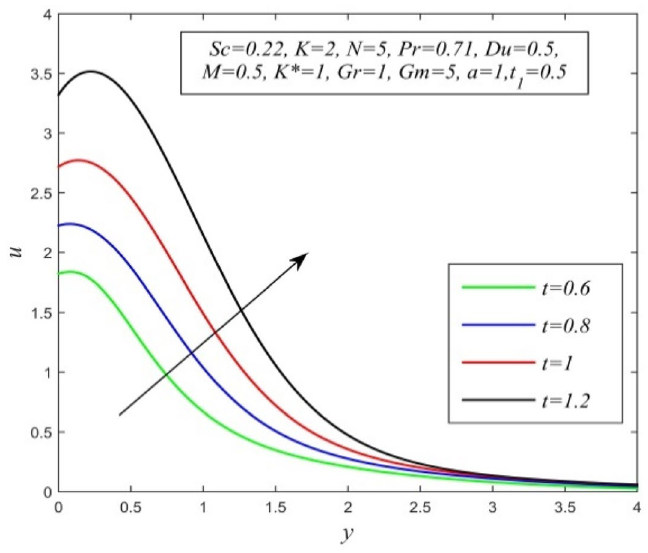
Figure 11. u versus y for different t and Sc = 0.22, K = 2, N = 5, Pr = 0.71, Du = 0.5, M = 0.5, K* = 1, Gr = 1, Gm = 10, a = 1, t 1 = 0.5.